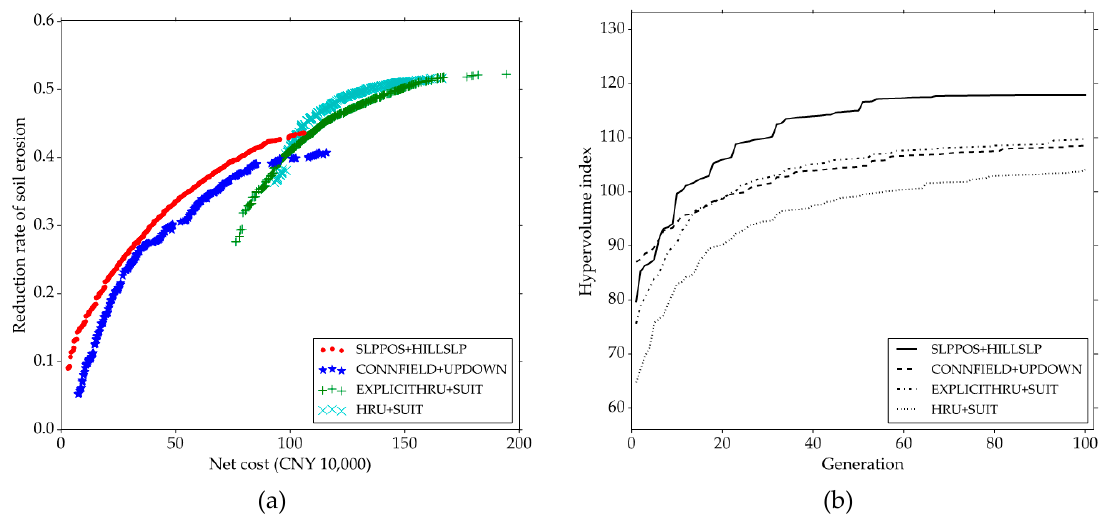
Figure 9. Comparisons among four types of BMP configuration units applied with the corresponding optimal configuration strategies: ( a ) near-optimal Pareto solutions of the 100th generation, and ( b ) the hypervolume index changed with generations.